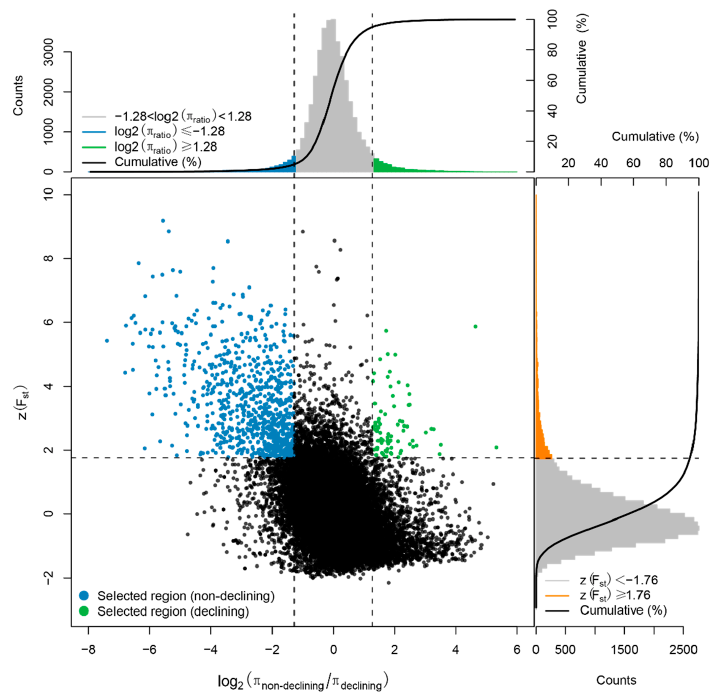
Figure 4. The distribution of candidate genomic regions detected by selective sweep analysis between non-declining populations and the declining population (BM population) based on θπ and Fst . Green points were identified as selective sweeps in the declining population (BM population) that passed the thresholds of log θπ ratio (the 5% right tail of the empirical θπ ratio distribution, log2( π ratio) ≥ 1.28) and Z-transformed Fst (the 5% right tail of the empirical Fst distribution, Z( Fst ) ≥ 1.76). Table 2. KEGG enrichment analysis of genes under selection of Method 1.